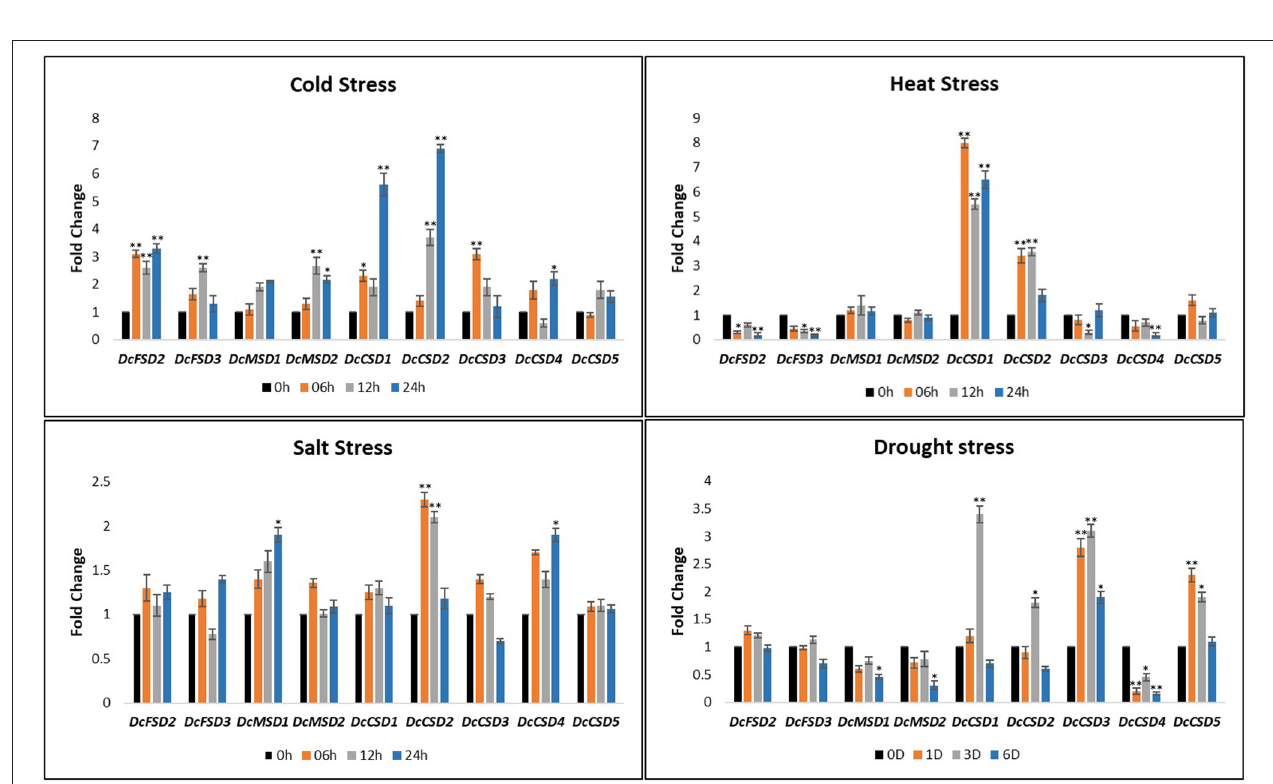
FIGURE 9 | Relative qRT-PCR expression verification of DcSODs genes under cold, heat, salt, and drought stress. In nontreated plants, one (01) was the default expression value for each gene. Significant change in expression is indicated by an asterisk ( p < 0.05 = > *, p < 0.01 = > **).